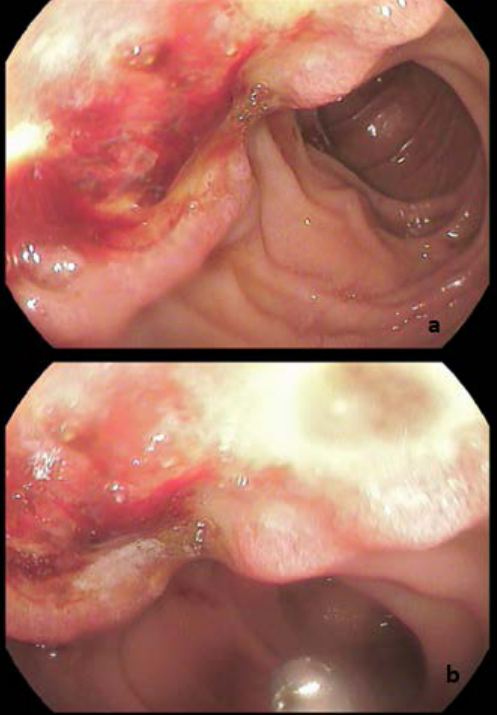
Figure 1. ( a , b ) Gastroduodenal endoscopy showed a large ulcerative ampullary lesion.